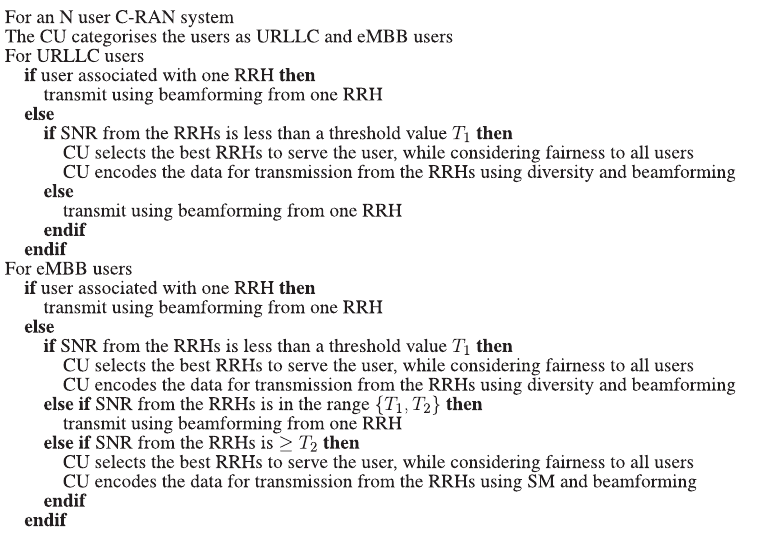
ALGORITHM 1 | Recon fi gurable MIMO transmission in